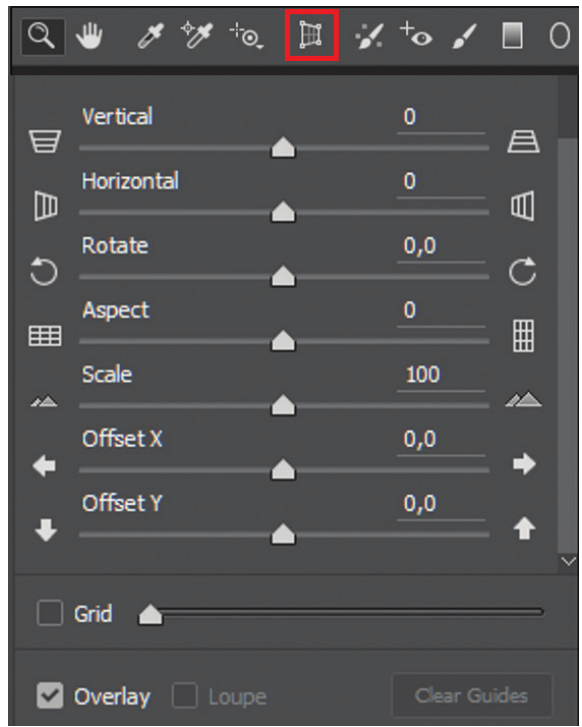
Figure 7. Tool transform